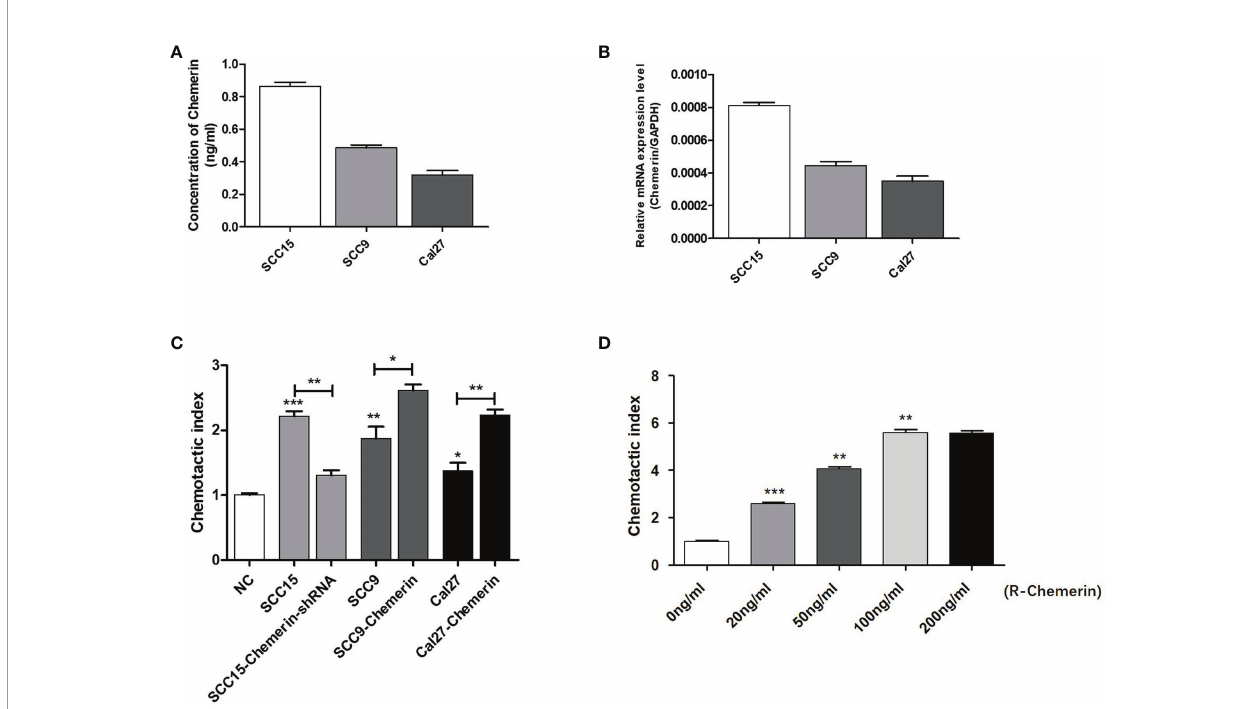
FIGURE 3 | OSCC cells expressing Chemerin attract neutrophils in vitro . (A) Supernatant Chemerin levels in OSCC cell lines were detected by ELISAs. (B) mRNA expression levels of Chemerin in OSCC cell lines were detected by qRT-PCR. (C) The effect of OSCC cells on neutrophils ’ chemotaxis was assayed using a transwell system. (D) The effect of R- Chemerin on neutrophils ’ chemotaxis was assayed using a transwell system at various concentrations (0-200 ng/ml). * P < 0.05; ** P < 0.01; *** P < 0.001.